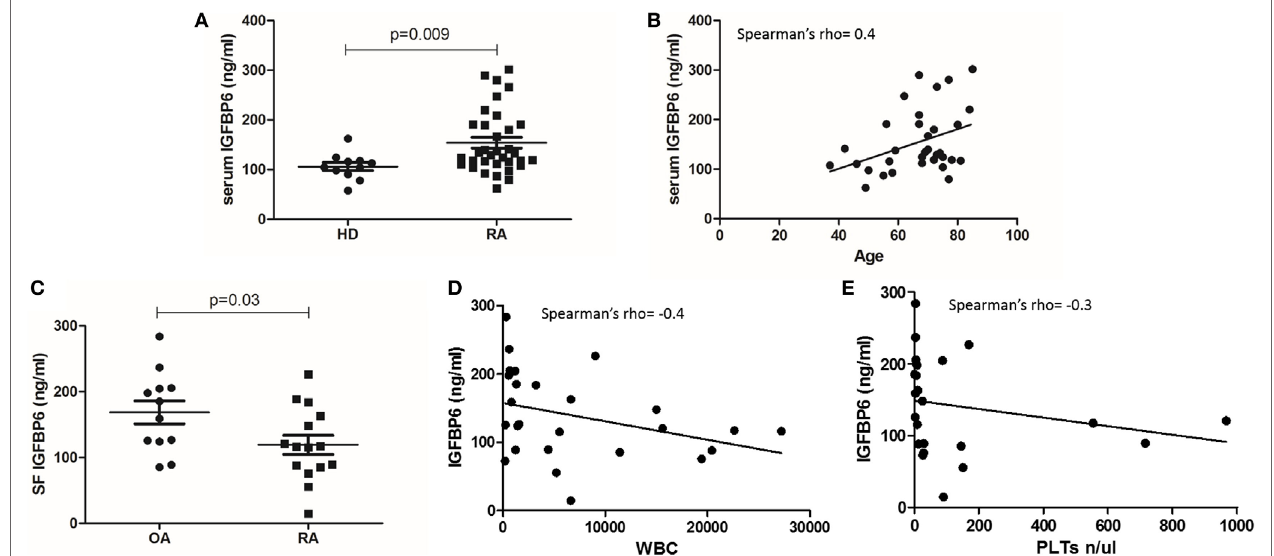
FigUre 1 | insulin-like growth factor binding protein 6 (igFBP6) expression in serum (a) of rheumatoid arthritis (ra) patients and healthy donors (hD) and in synovial fluid (sF) of ra patients and osteoarthritis (Oa) controls (c) . IGFBP6 concentration is significantly higher in RA serum compared to HD and is significantly lower in RA SF compared to OA SF. Correlation between serum IGFBP6 and patients’ age (B) , SF IGFBP6 and SF white blood cell (WBC) count (D) , and SF platelet (PLT) count (e) . SF IGFBP6 concentration is inversely correlated to both SF WBC and PLT counts. p values shown in panels (a,c) were calculated with Mann–Whitney U